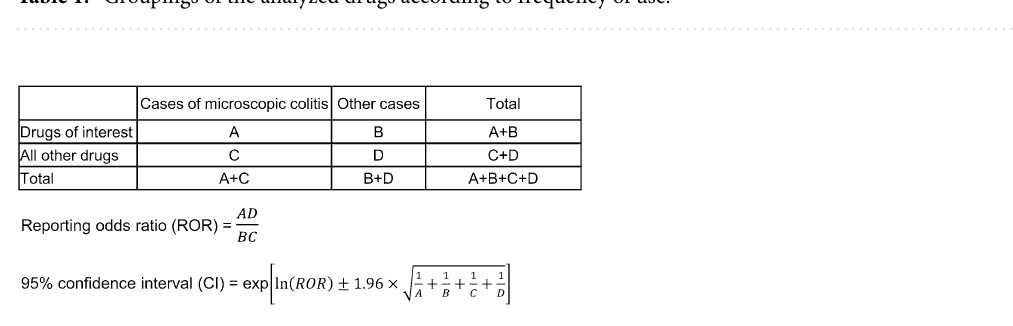
Table 1. Groupings of the analyzed drugs according to frequency of use.